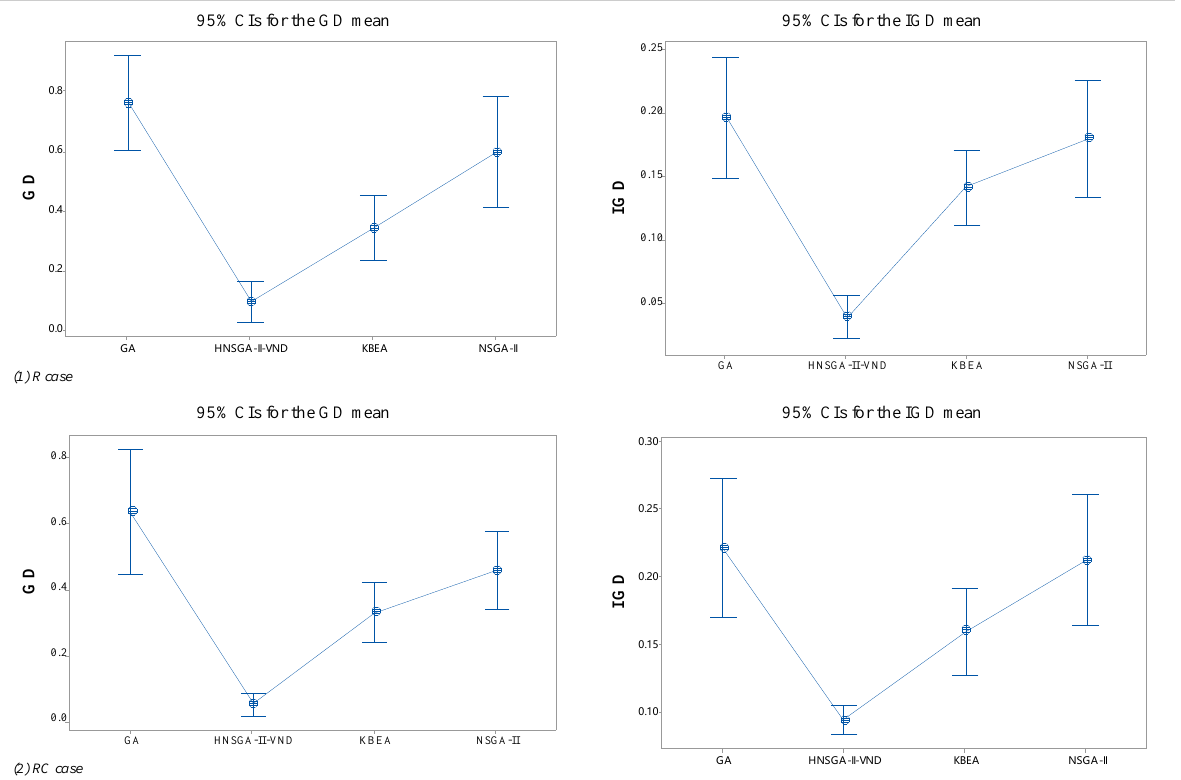
Figure 9. The comparison interval diagram of all the algorithms at 95% CIs.